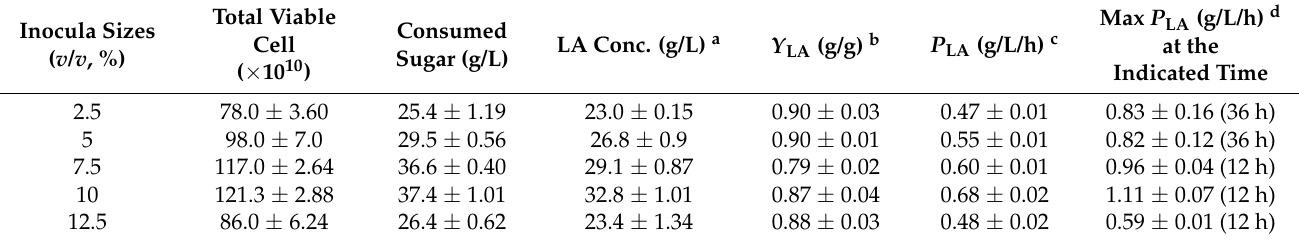
Table 6. Effect of inocula sizes of CSW on the growth, sugar consumption, LA concentration, LA yield, LA productivity, and maximum LA productivity by E. faecium